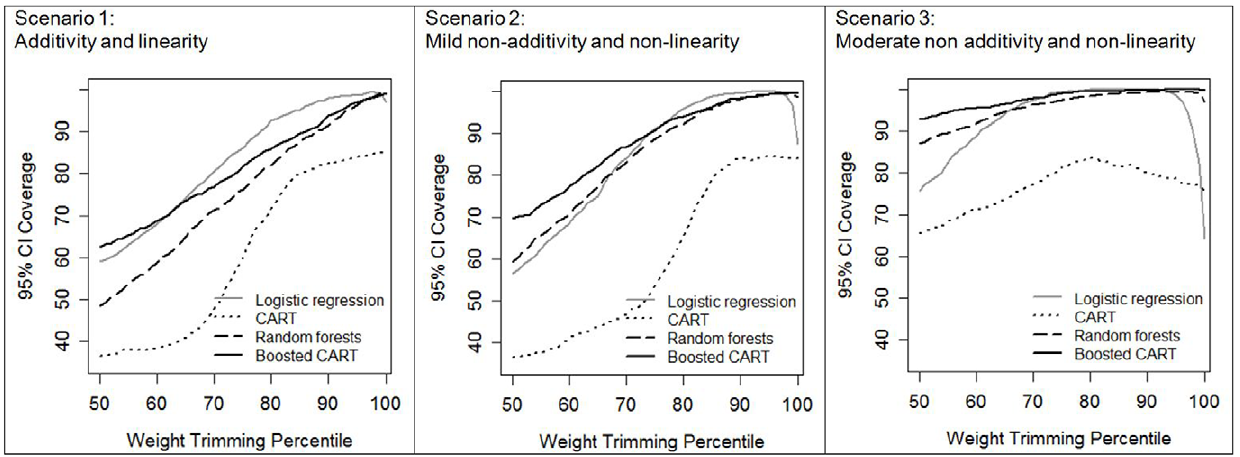
Figure 3. 95% confidence interval coverage for 1000 simulated datasets of N=500 after propensity score weight trimming, by propensity score estimation method and degree of complexity in the true propensity score model scenario. Scenario 1: additivity and linearity; Scenario 2: mild non-additivity and non-linearity; Scenario 3: moderate non-additivity and non-linearity. The 100th percentile of weight trimming indicates no trimming was applied.